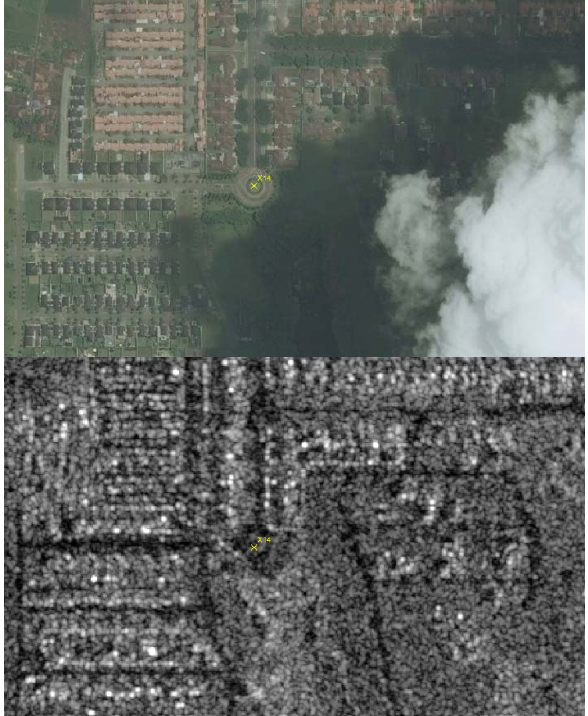
Figure 6. GCPs from Bing (upper) and TSX